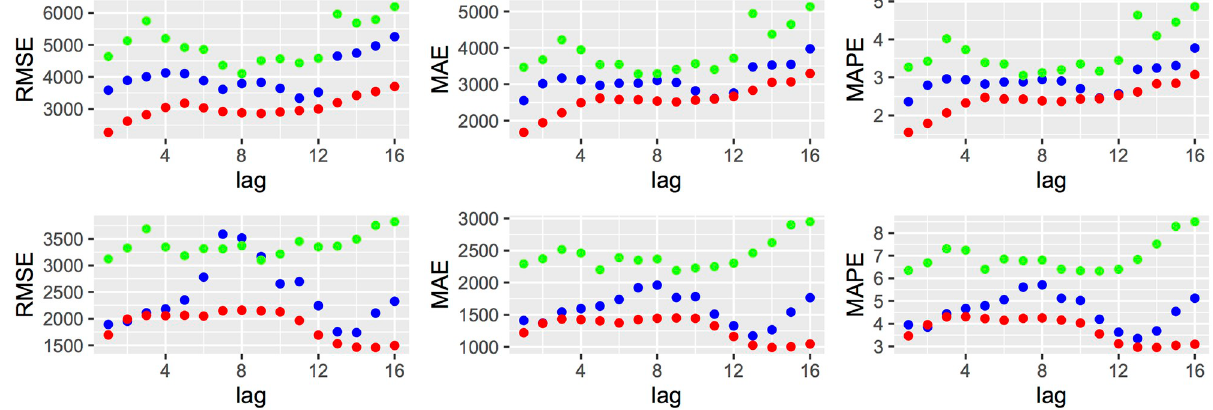
Fig 2. Accuracy measures from cross–validation. First row: Brazil; second row: Spain; ALNB(green), ARIMA(red) and ETS(blue).